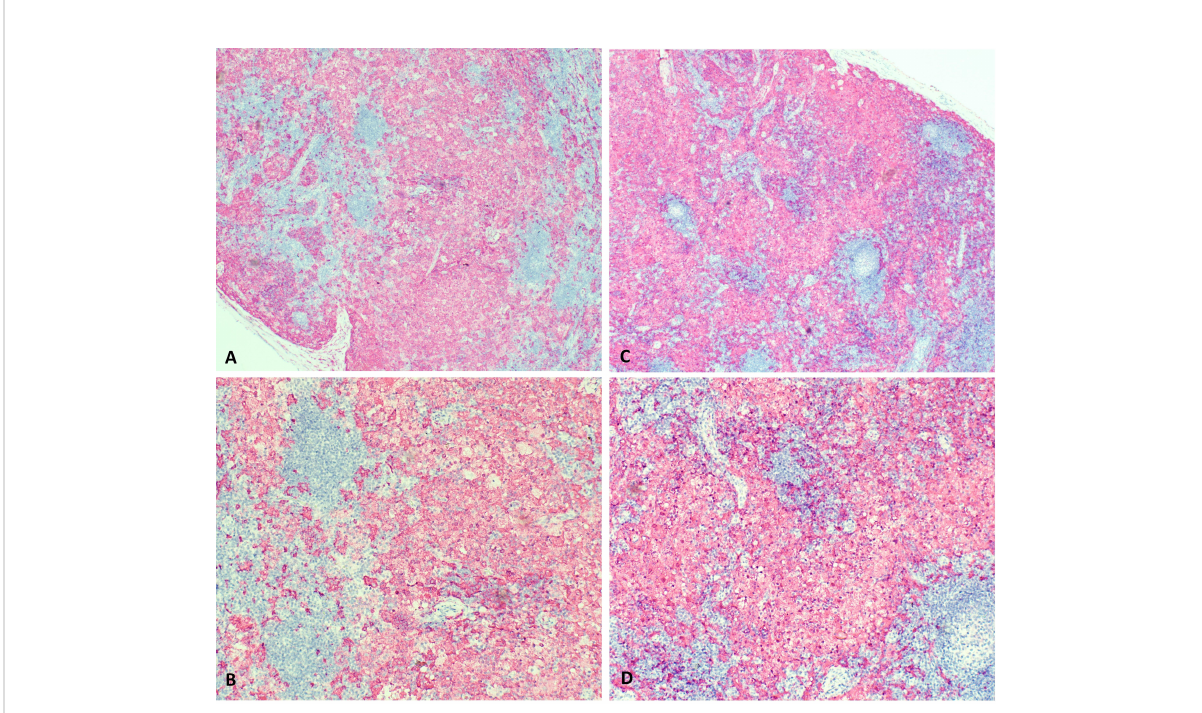
FIGURE 2 On immunohistochemical staining, the histiocytic cells are S100+, CD31+, CD68+, CD163+, CD14+, Fascine+, CD34 nonspeci fi c, CD1a- and Langherine-. ( A, C : 5x magni fi cation; B, D : 10 x magni fi cation).